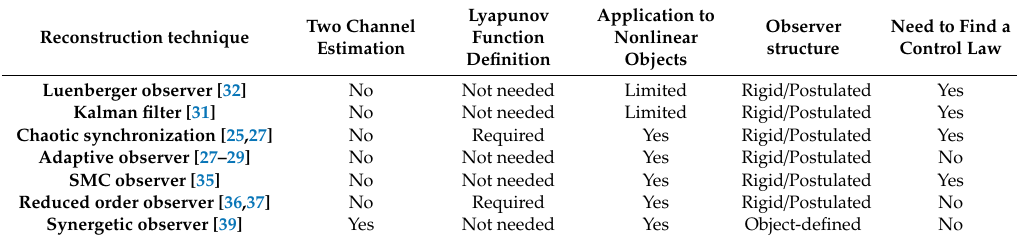
Table 1. Signal reconstruction techniques features